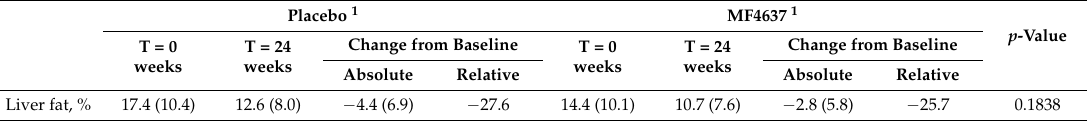
Table 4. MRI-PDFF liver fat percentage at baseline and after 24-week intervention with placebo or MF4637. Placebo 1 MF4637 1